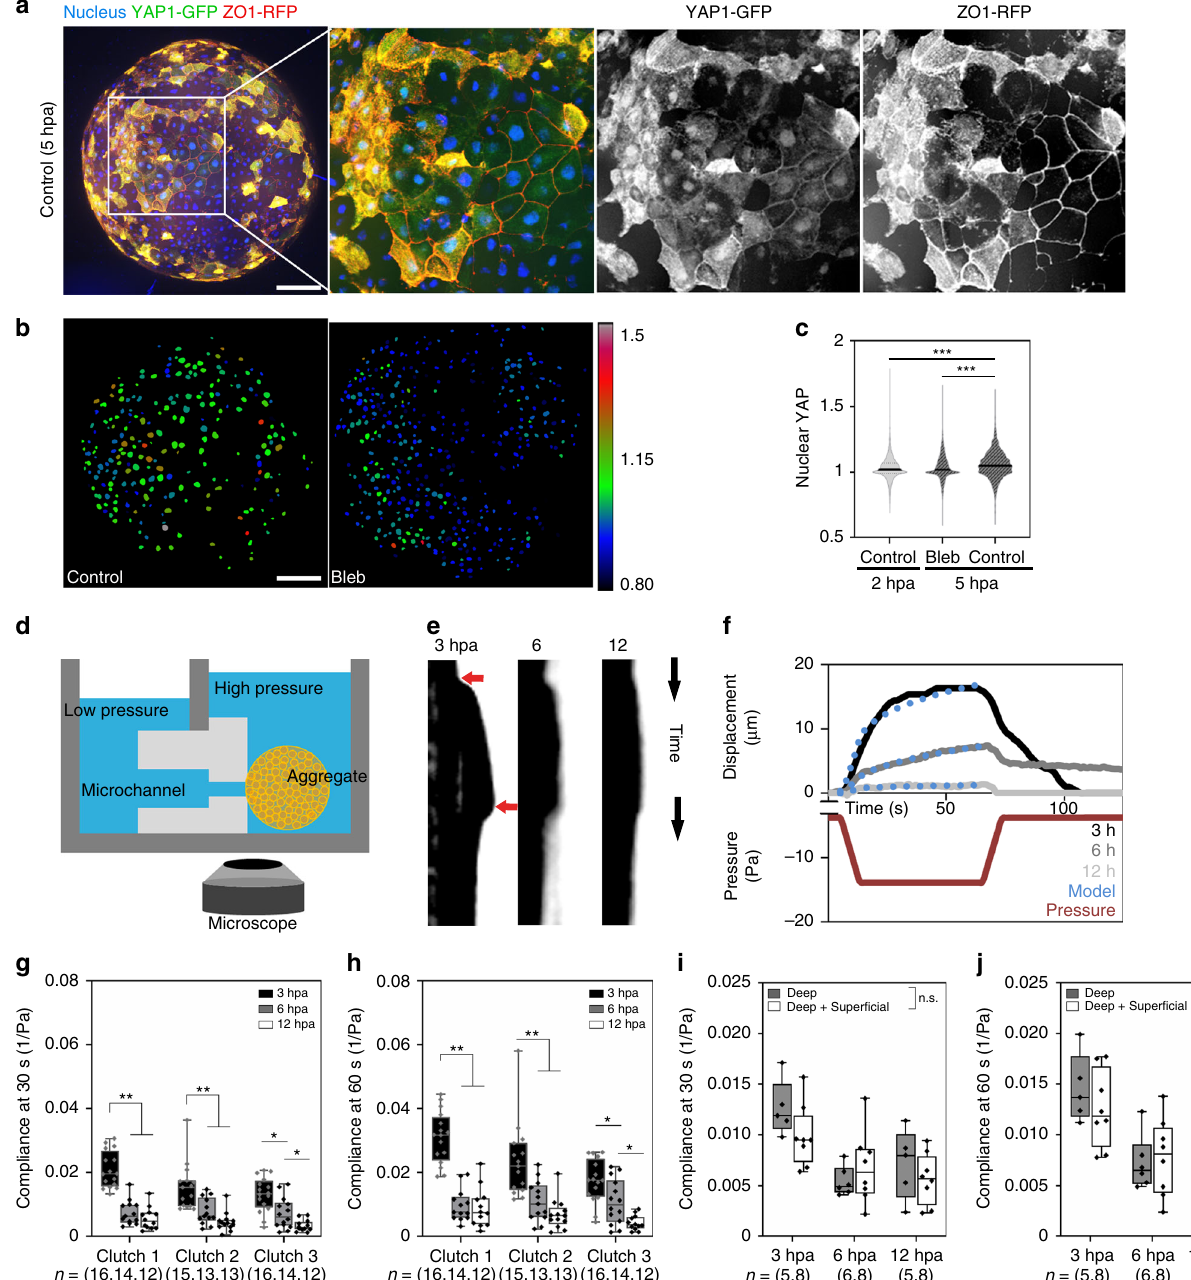
Fig. 3 YAP nuclear translocation and tissue stiffening both coincide with epithelialization. a Maximum intensity projection of deep ectoderm aggregate expressing YAP1-GFP and ZO-1-RFP and stained for nuclei. Scale bar, 100 µ m. b Color coded nuclear YAP ratios for control and blebbistatin treated deep ectoderm aggregates at 5 hpa. Scale bar, 100 µ m. c Nuclear YAP ratios of 5 hpa aggregates ( n = 2040 nuclei from 7 aggregates) are higher than blebbistatin-treated aggregates (3471 nuclei from 7 aggregates) and 2 hpa aggregates (2167 nuclei from 7 aggregates). Statistical analysis from one-way ANOVA followed by Tukey multiple comparison test (*** P < 0.001). d Schematic of micro-aspirator used to measure tissue compliance of aggregates by adjusting pressure at the opening of the microchannel (see Methods). e Representative kymographs of tissue displacement over the length of representative micro-aspiration experiments at 3, 6, and 12 hpa. Red arrows indicate the time suction pressure is applied and then released. f Aspirated distances of an aggregates in ( e ) at 3 (black), 6 (dark gray), 12 hpa (light gray) relative to the pressure applied (red). The power-law model of creep compliance (blue dots) fi t to this data. g , h Creep compliance at 30 and 60 s indicating steady-state from micro-aspiration at 3 (black), 6 (gray) and 12 hpa (white). 12 to 16 aggregates were measured for each time point and repeated over three clutches. i , j Creep compliance at 30 and 60 s from micro- aspiration of aggregates consisting of only deep mesenchymal cells (gray) or both deep mesenchymal and super fi cial epithelial cells (white) 3, 6, and 12 h post aggregation (one clutch, n = 5 – 8 aggregates each). g – j Box plots show minimum, fi rst quartile, median, third quartile, and maximum values. Statistical analysis by Mann – Whitney U-test is shown as either not signi fi cant (n.s.) or by asterisk (* P < 0.05; ** P < 0.01; *** P <